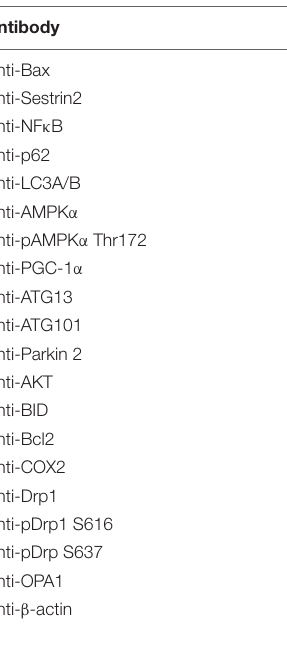
TABLE 2 | List of primary